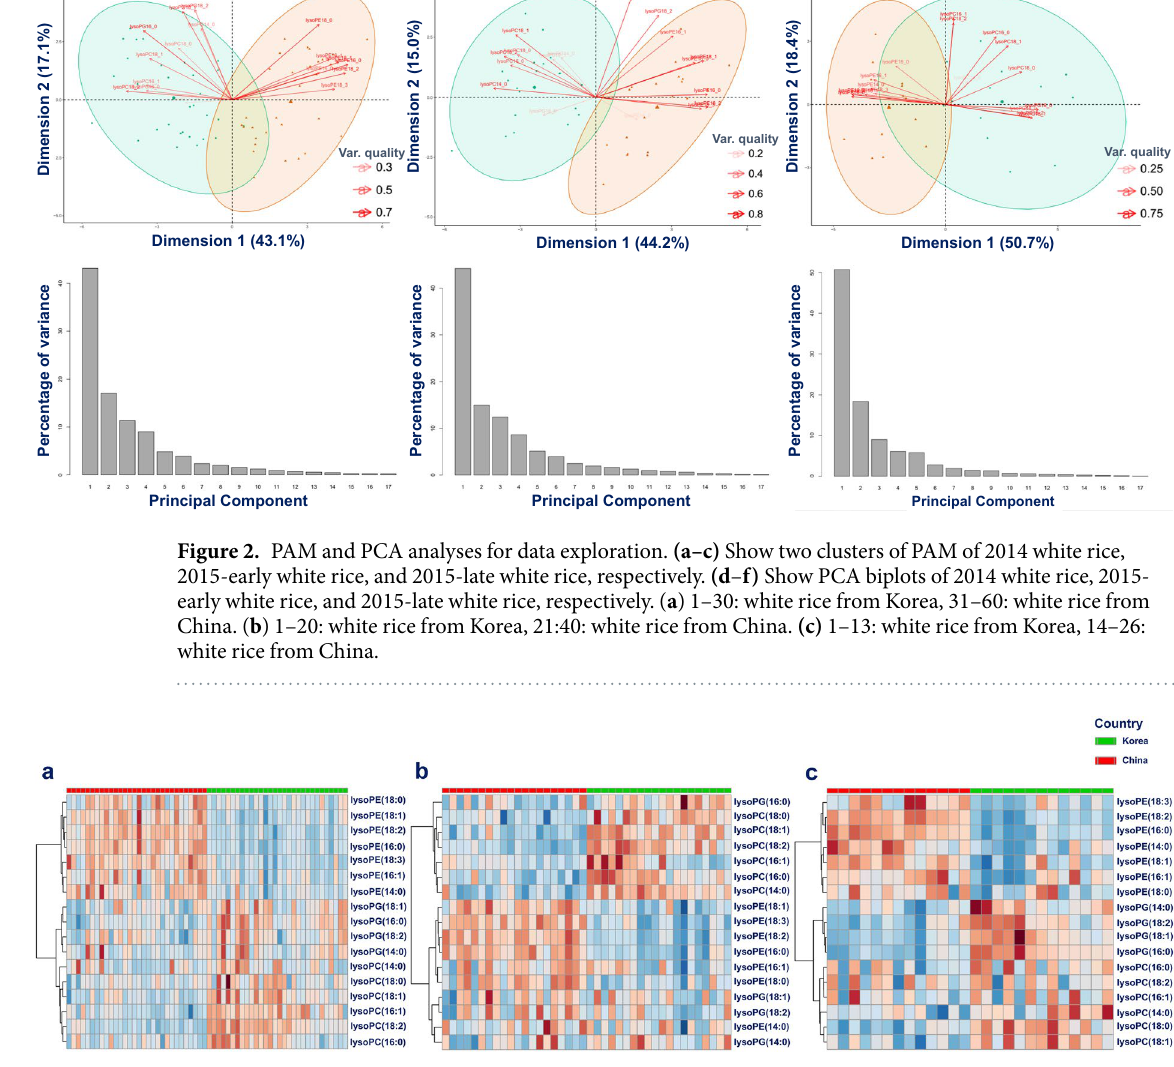
Figure 3. Heatmaps show the relative difference of concentrations of 17 lysoGPLs of (a) 2014 white rice, (b) 2015-early white rice, and (c) 2015-late white rice,